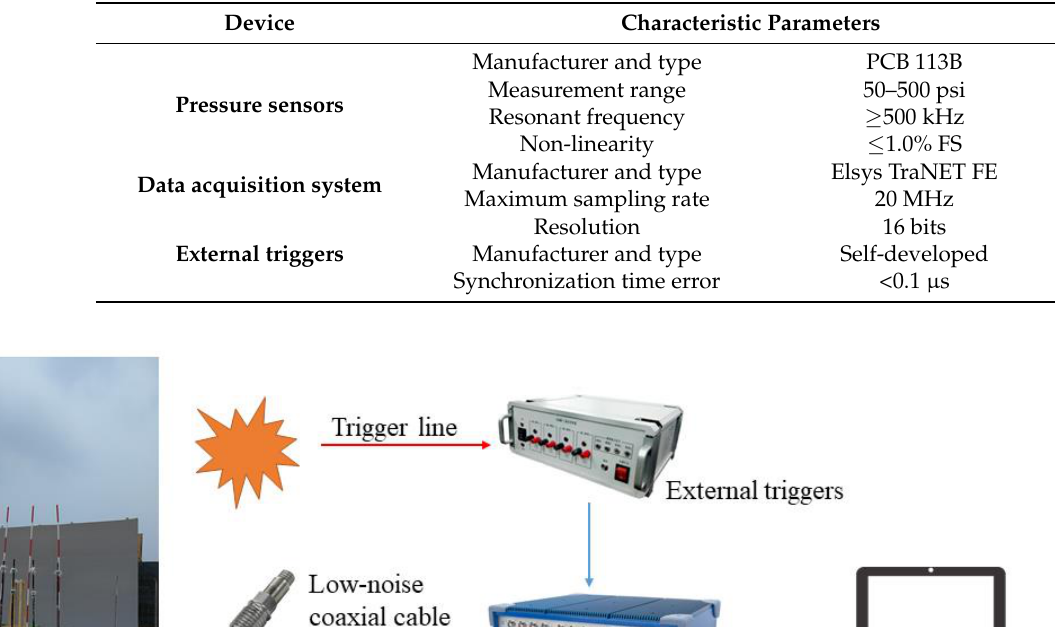
Table 2. Parameters of the devices used in the experiments.